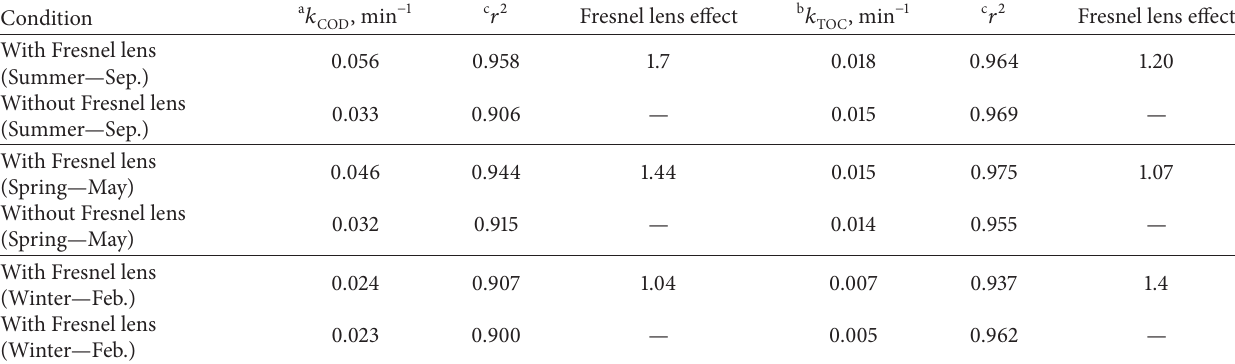
Table 4: Effect of Fresnel lens on IPCC for treatment of the electro-optical industry wastewater in different seasons. − 1 Condition a 𝑘 COD , min With Fresnel lens